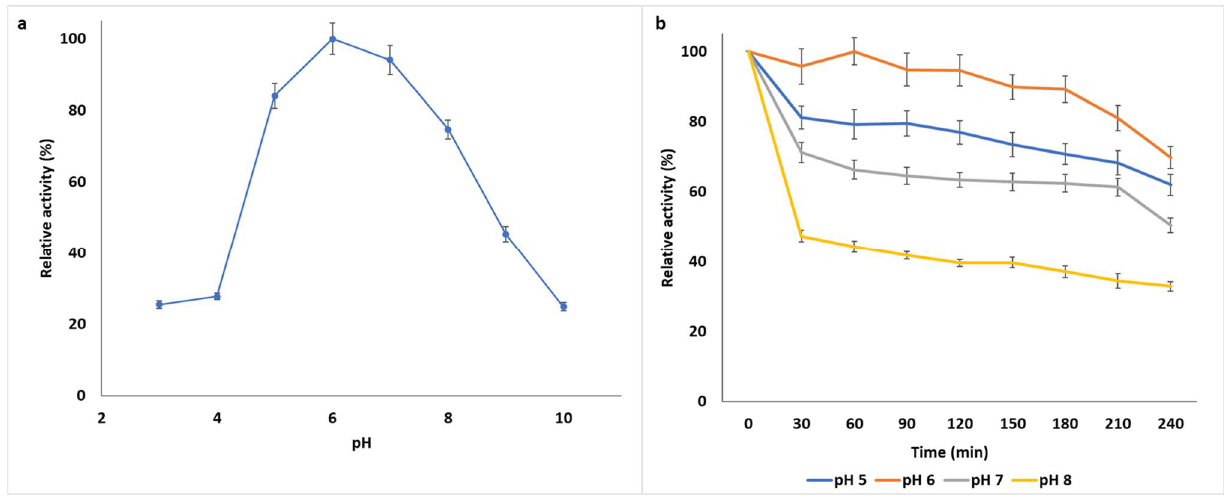
Figure 2. ( a ) Effect of pH on the activity of Beauveria bassiana SAN01 xylanase; ( b ) Effect of pH on the stability of Beauveria bassiana SAN01 xylanase; each point represents the mean ( n = 3) ± SD.